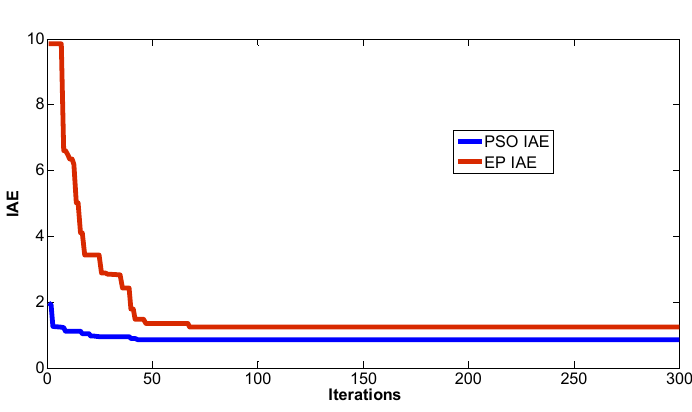
Figure 6. IAE convergence curve.